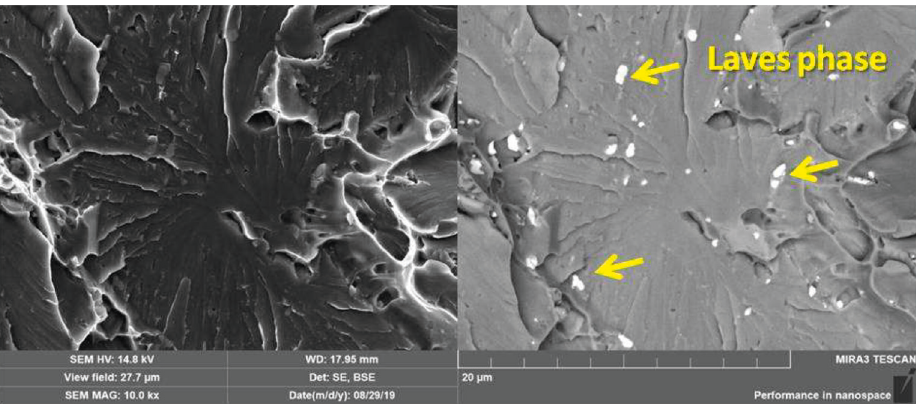
Figure 9: The impact fracture morphologies of G115 steel aged at 700 ° C for 500h.